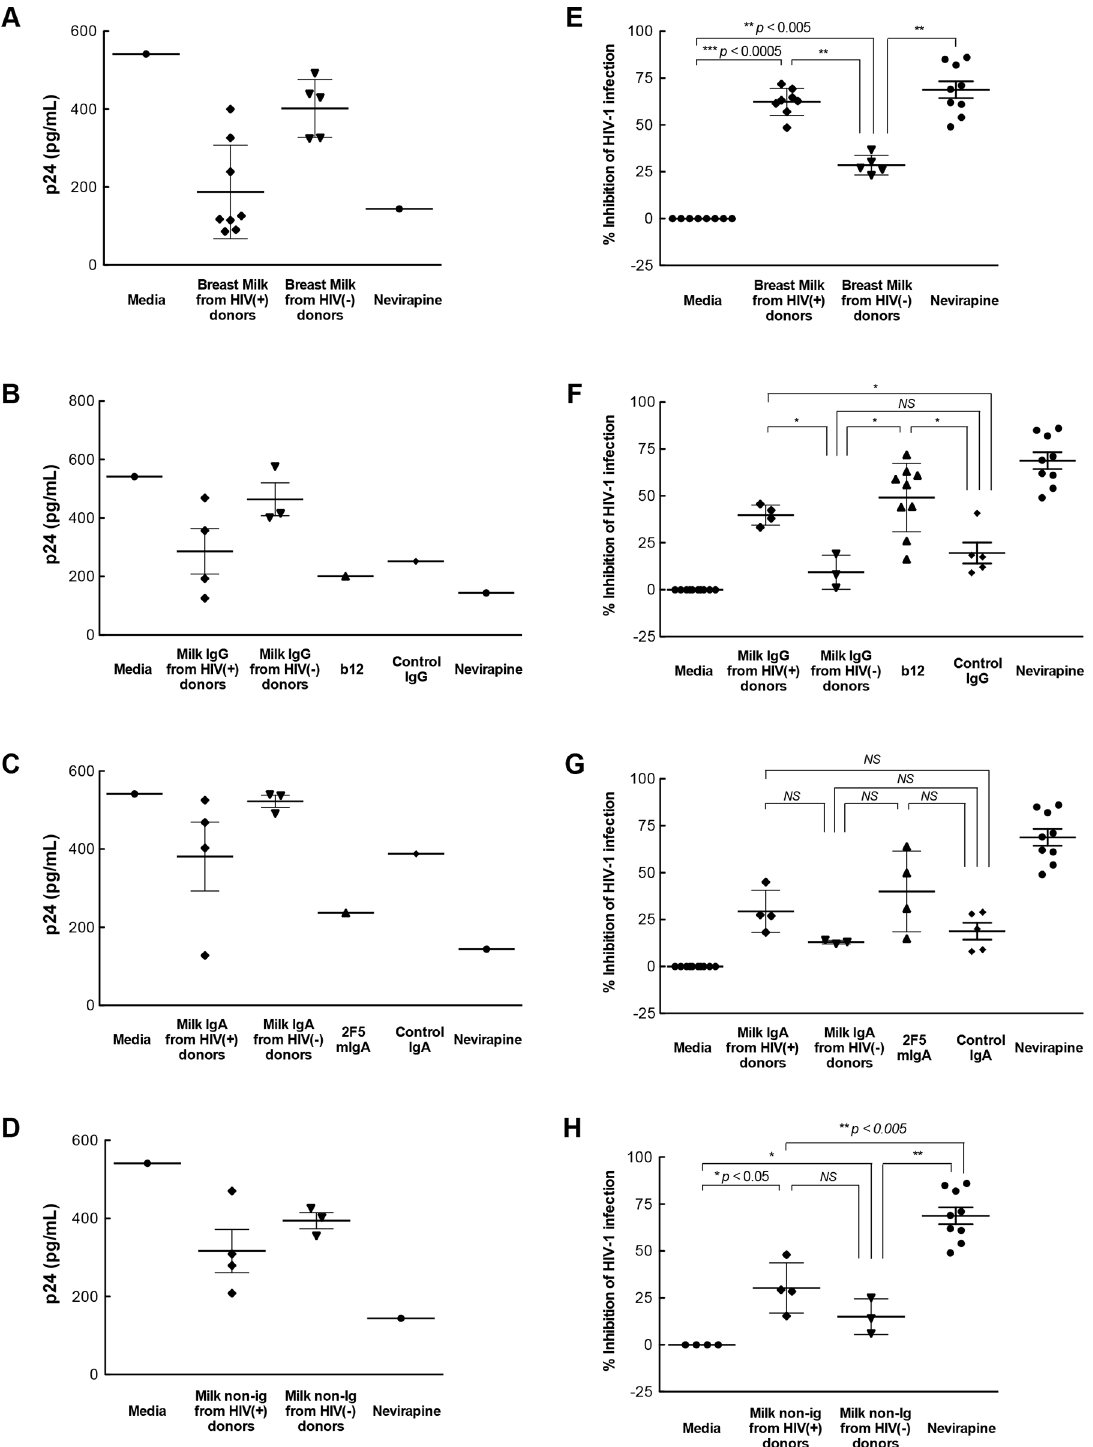
Fig 5. HIV-1 replication in intestinal mucosa. Ugandan subtype A HIV-1 was pre-incubated with (A, E) breast milk or the corresponding (B, F) IgG, (C, G) IgA or (D, H) non-Ig components (diluted 1:2) for 30 min and inoculated onto the apical surface of explanted intestinal mucosa. After 2 hr incubation, the mucosa was trypsinized, incubated for 3 days and HIV-1 replication was measured by p24 released into the media normalized to tissue weight. Results in panels A-D are p24 values from a representative tissue donor. Values in panels E-H represent the mean percent inhibition of HIV-1 infection in intestinal tissue from 3 – 5 different donors by each breast milk. For control antibodies and Nevirapine control, each dot point represents a mean value from a separate